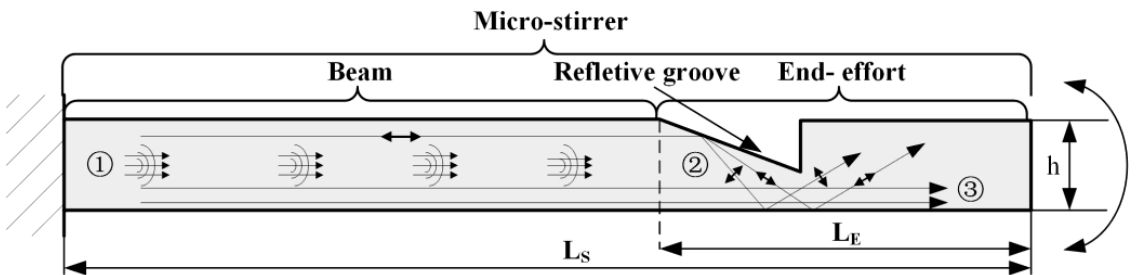
Figure 2. Schematic diagram of micro-stirrer ① Input longitudinal elastic wave, ② Mode conversion from longitudinal to transversal vibration, ③ Propagating longitudinal elastic wave.